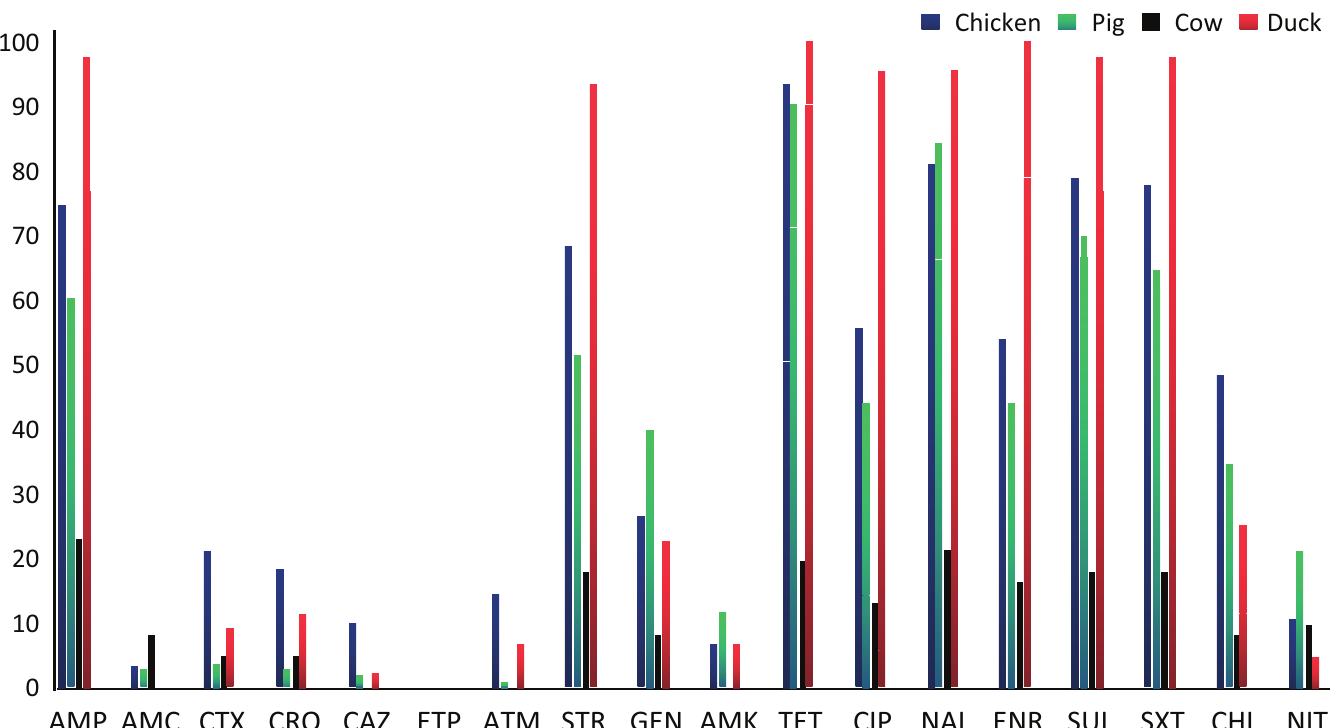
Fig 1. Antimicrobial resistance to 18 antibiotics of E . coli isolates from different food animal sources. The columns denote the percentages of resistant isolates for individualanimal species(chicken, pig, cow and duck). AMP, ampicillin; AMC, amoxicillin/clavulanicacid; CTX, cefotaxime; CRO, ceftriaxone; CAZ, ceftazidime; ETP, ertapenem; ATM, anaztreonam STR, streptomycin; GEN, gentamicin; AMK, amikacin; TET, tetracycline; CIP, ciprofloxacin; NAL, nalidixicacid; ENR, enrofloxacin; SUL, sulfisoxazole;SXT, trimethoprim/sulfamethoxazole;CHL, chloramphenicol;NIT, nitrofurantoin.